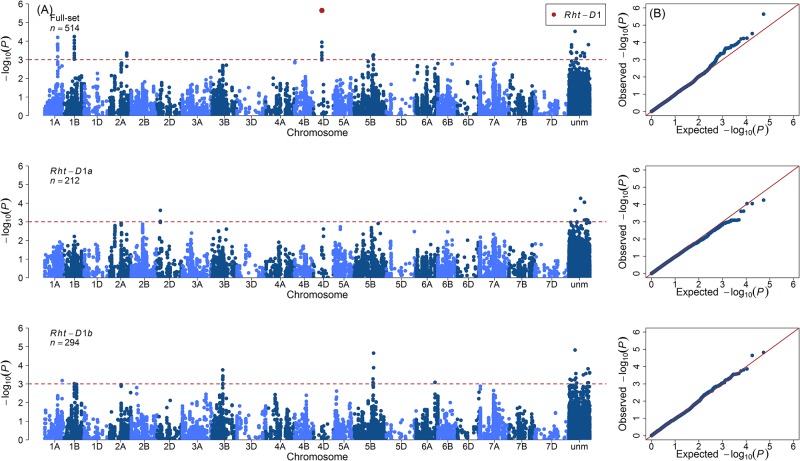
Summary of genome-wide association studies (GWAS) for anther extrusion in different wheat panels.(A) Manhattan plot based on linear mixed model using kinship matrix for correction of population stratification. (B) Quantile-quantile plot depicting expected versus observed P values at −log10 scale. Full-set represents the GWAS results of varieties harboring both Rht-D1a and Rht-D1b alleles. Rht-D1a and Rht-D1b set represent the GWAS results in individual panels harboring either of the alleles. n denotes the total number of varieties used in GWAS panels.